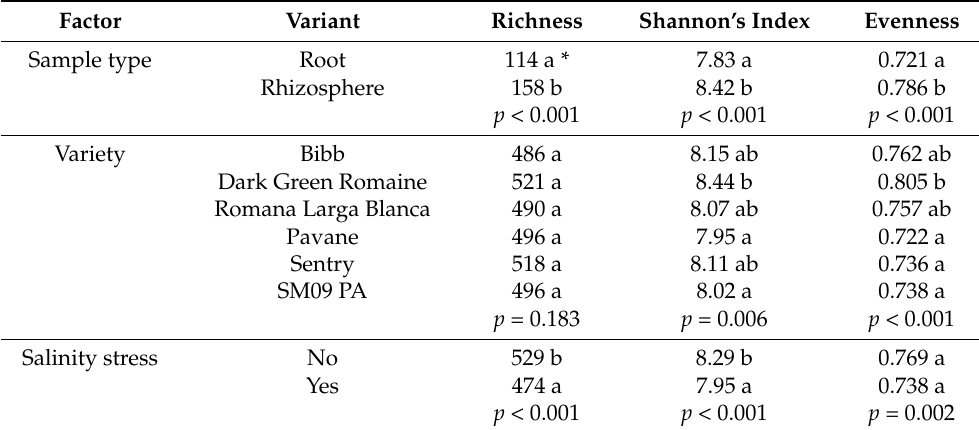
Table 1. Alpha diversity indices of bacterial microbiomes in root and rhizosphere of six varieties of lettuce under normal conditions and salinity stress.